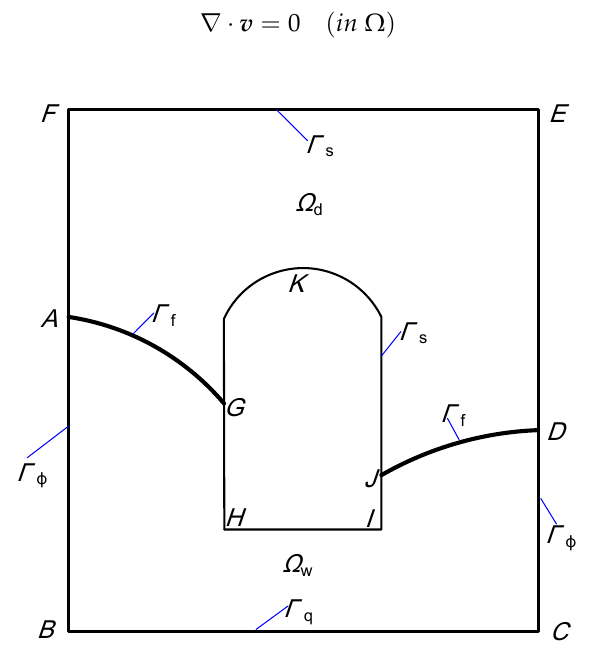
Figure2. Sketch of seepage flow through an underground cavern. Figure 2. Sketch of seepage flow through an underground